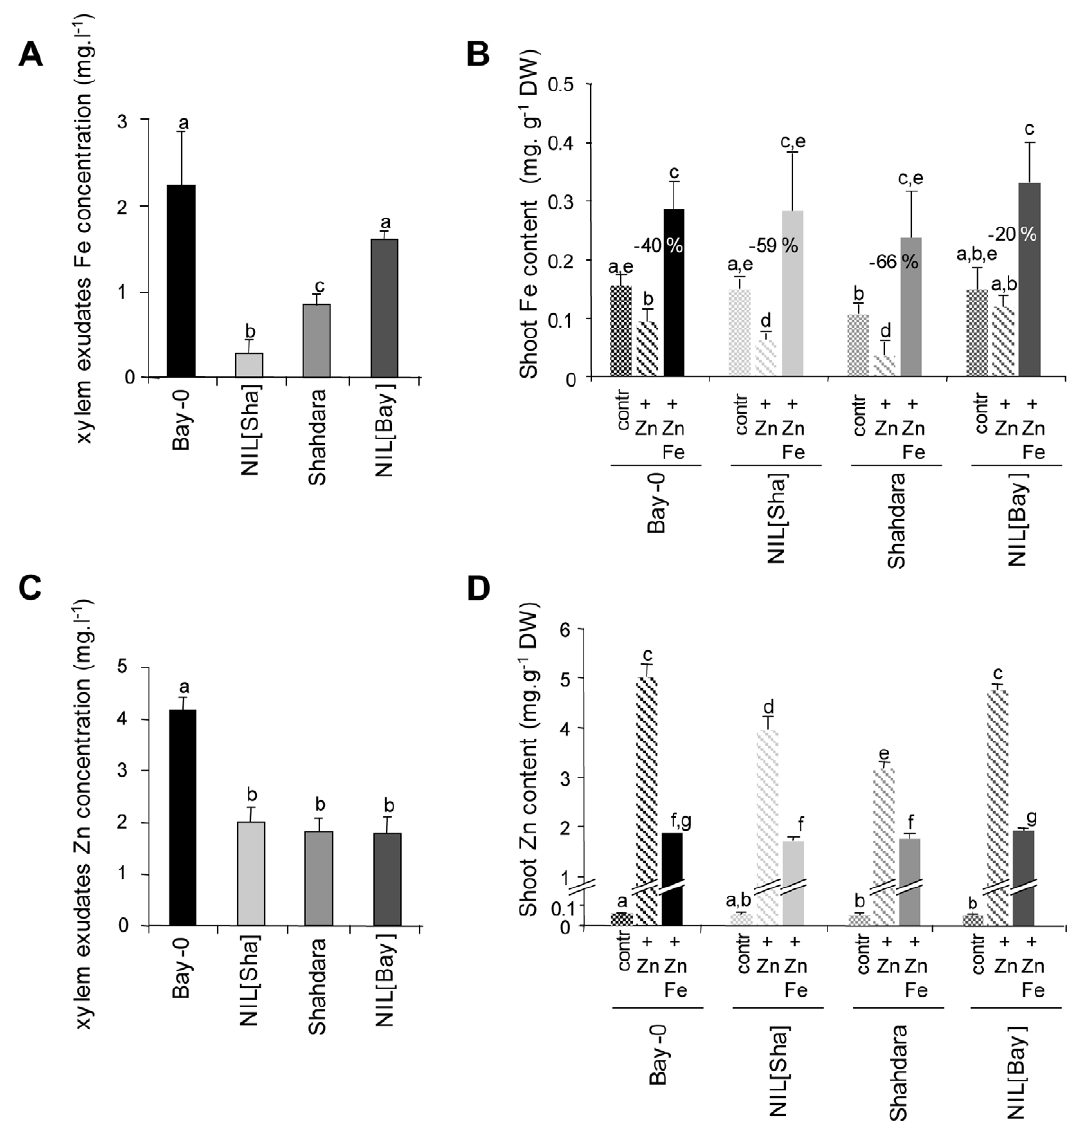
Figure 4. Fe and Zn homeostasis in NILs and parental lines. Fe (A) and Zn (C) concentrations in xylem exudates. Plants were grown in a growth chamber for 6 weeks and xylem exudates were collected during 30 min after removing aerial parts of the plant at the hypocotyl. Fe (B) and Zn (D) shoot content. Plants were grown on agar plates under control (contr.), 200 m M Zn ( + Zn), and 200 m M Fe plus 200 m M Zn ( + Zn Fe) conditions for 10 days. Percentages given above bars in (B) refer to the difference in shoot Fe content in ‘ + Zn’ conditions as a percentage of the control value. Measurements were performed on sets of 5 to 20 plants. Values are the means 6 S.D.M. Different letters above bars refer to significantly different values (P , 0.05), according to non-parametric tests for (A), (B) and (D) and Tukey tests for (C) where